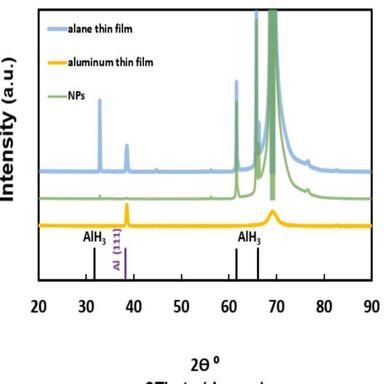
XRD analysis of AlH3 thin films and nanoparticles, displaying their distinct crystallographic phases. The top sections display the diffraction patterns of the AlH3 thin film and AlH3 nanoparticles. These patterns are compared with the standard reference for an aluminum thin film, which is shown at the bottom for baseline comparison.